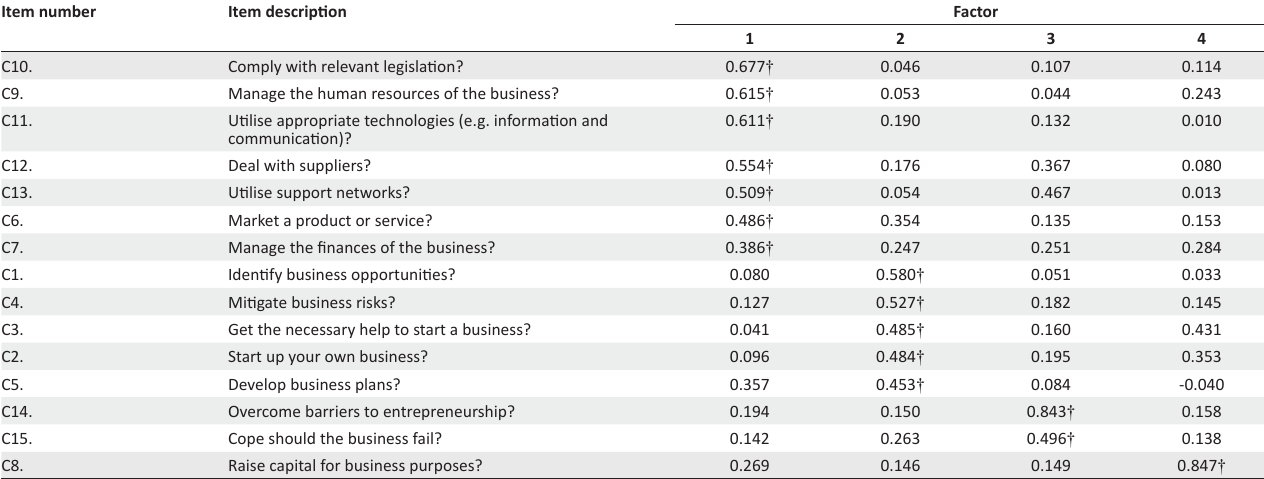
TABLE 7: Rotated factor matrix for Part C of the questionnaire (perceived behavioural control). Item number